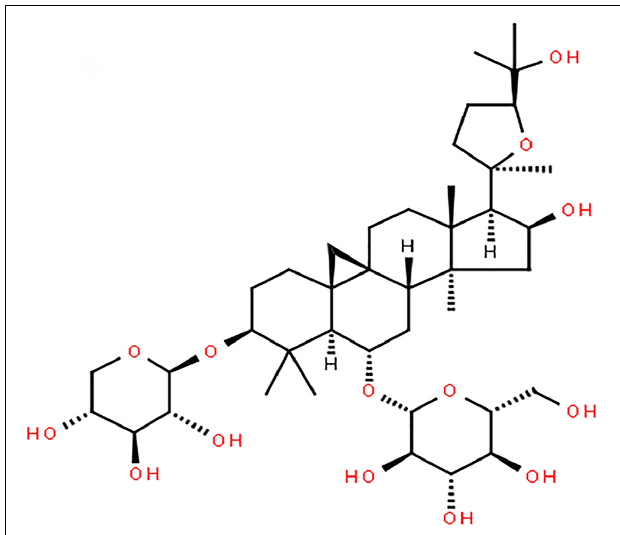
FIGURE 1 | Chemical structure of Astragaloside